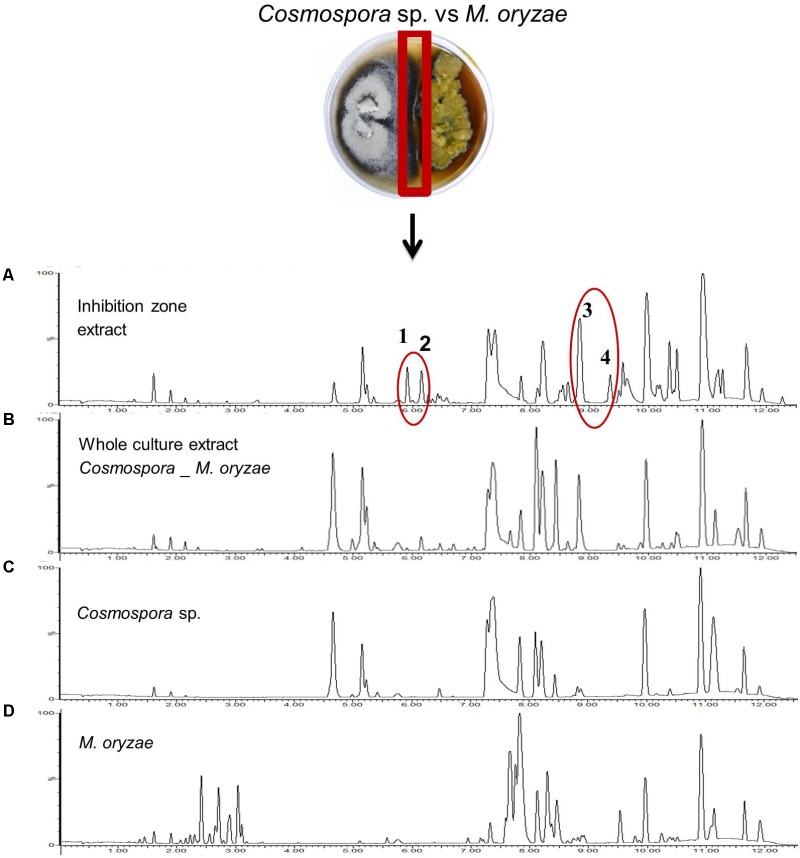
Base peak chromatograms of the extracts obtained from (A) the confrontation zone of the co-culture of Cosmospora sp. and M. oryzae, (B) the whole co-culture, and mono-cultures of (C)
Cosmospora sp., and (D)
M. oryzae. Four distinct unannotated peak ions are induced in the co-culture: m/z [M+H]+ 309.0810, C14H29O7 (1), m/z [M+H]+ 307.1708, C14H27O7 (2), m/z [M+H]+ 293.1942, C14H29O6 (3), and m/z [M+H]+ 329.2318, C18H33O5 (4).